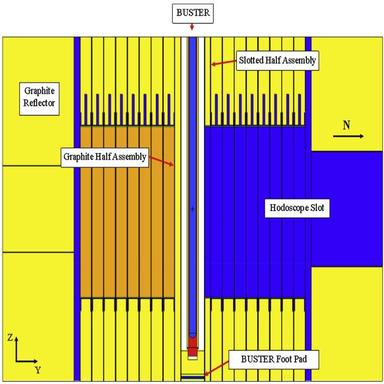
Vertical Plot (YZ-Plane) of BUSTER Loaded into the TREAT Experiment Slot for the Half-Slotted Core Conguration.